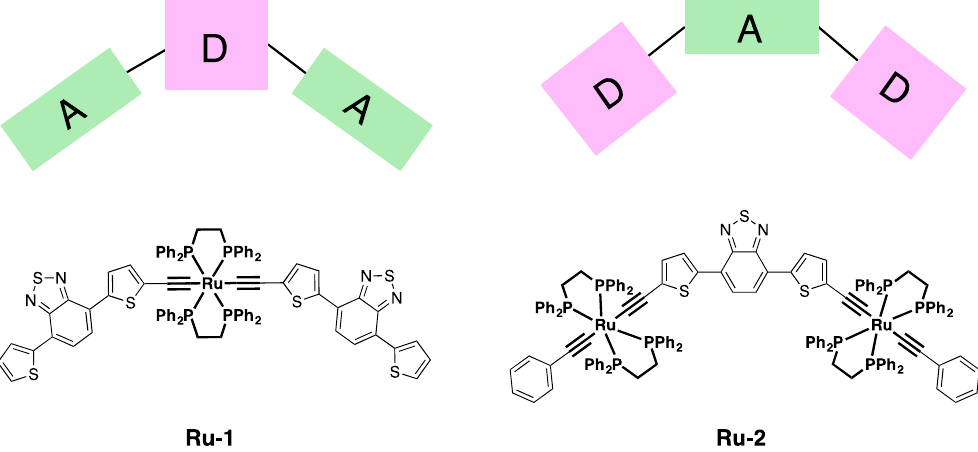
Figure 1. The chemical structures of the Ru(II) complexes studied and the design motif with electron donor (D) and acceptor (A) moieties.